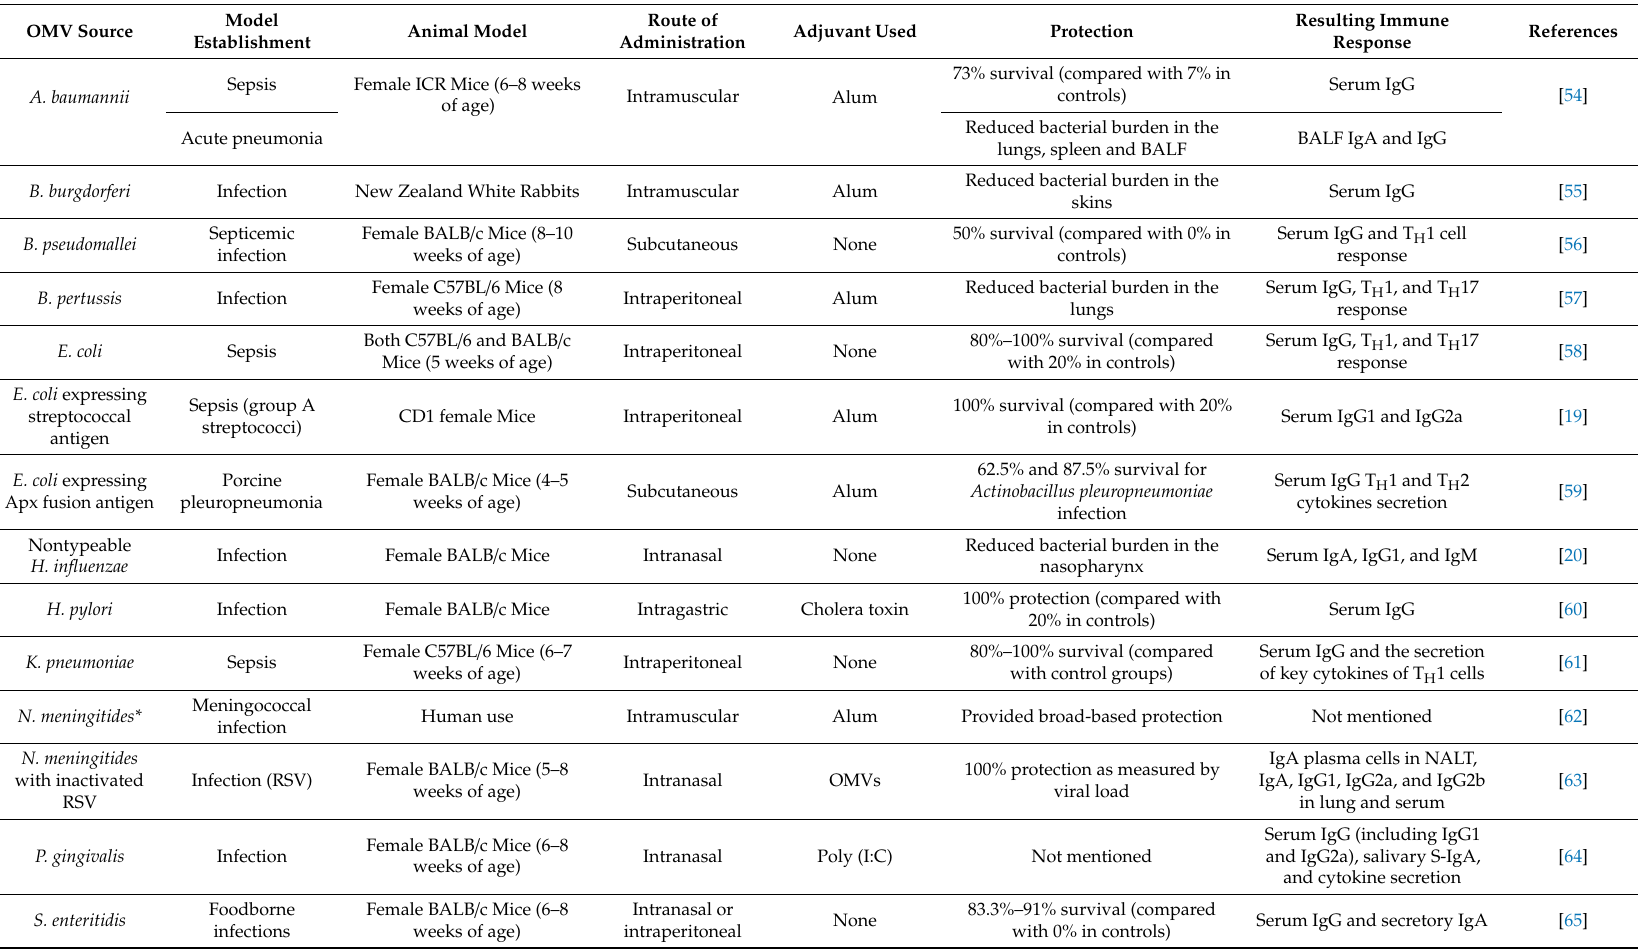
Table 1. Outer membrane vesicle-based vaccine against infection in preclinical